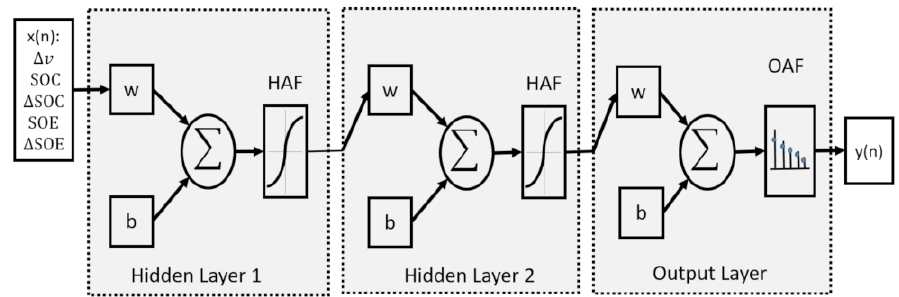
Figure 9. Architecture for pattern recognition feed-forward artificial neural network (ANN) for SOH classification. x(n): input; w: weight of layer neurons; b: bias of the layers; HAF: hidden layer activation function; OAF: output layer activation function.